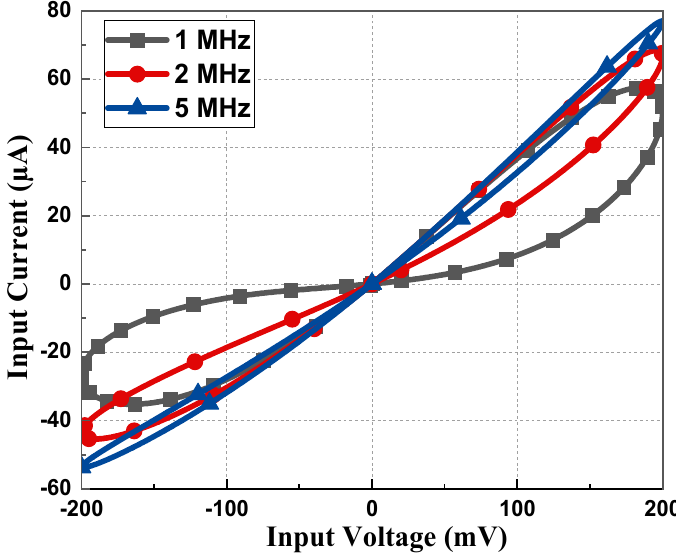
Sensors 2023 , 23 , x FOR PEER REVIEW